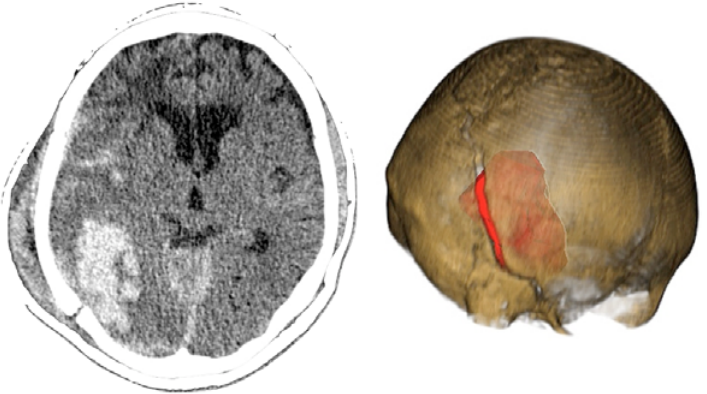
Figure 5. CASE 3. Preoperative CT scans. The 3-D environment with transparency control